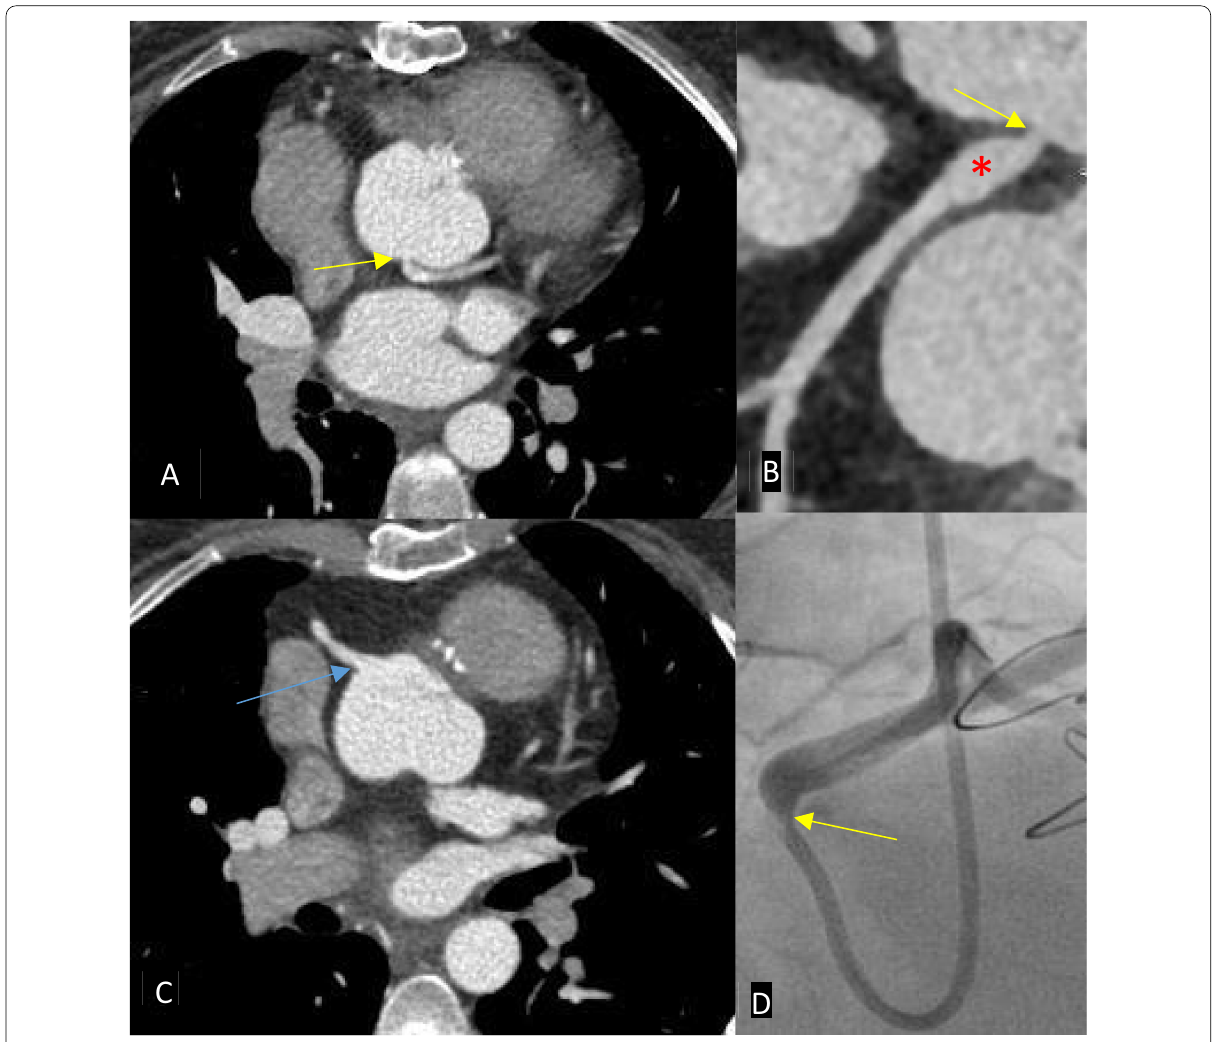
Fig. 21 Select coronary CT angiography images ( A , B , C ) in a patient post-coronary artery translocation. A Axial view showing ostial stenosis of the LCA (yellow arrow). B Reconstructed view of the LCA showing ostial stenosis (yellow arrow) and post-stenotic dilatation (red asterisk). C Axial view showing the normal ostium of the RCA (blue arrow) for comparison. D Catheter angiogram of the LCA showing ostial stenosis (yellow arrow). LCA: left coronary artery; RCA: right coronary artery